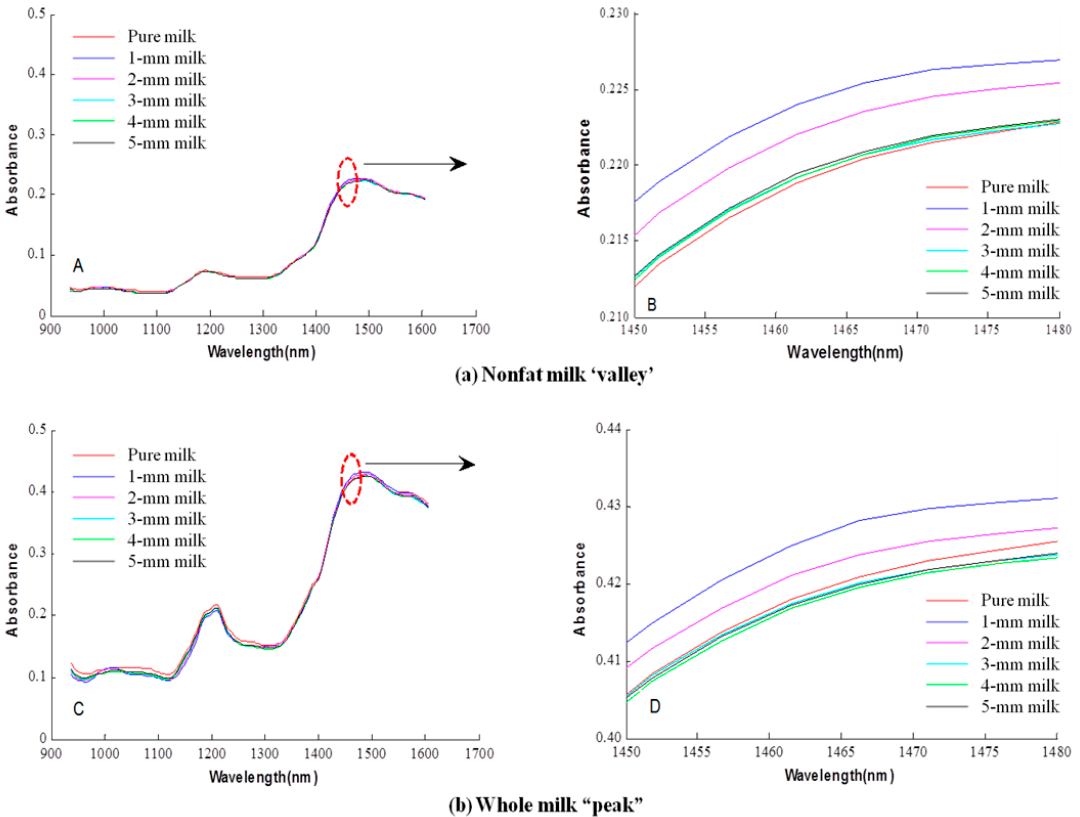
Figure 4. Mean ROI spectra of samples prepared using ( a ) ‘valley’ (N) nonfat milk and ( b ) ‘peak’ (W) whole milk, including pure milk samples and milk-melamine samples with milk depths from 1–5 mm (thickness). Plots A and C show the full spectra, while Plots B and D show the enlarged view of the mean spectra near the 1466.3-nm melamine peak.